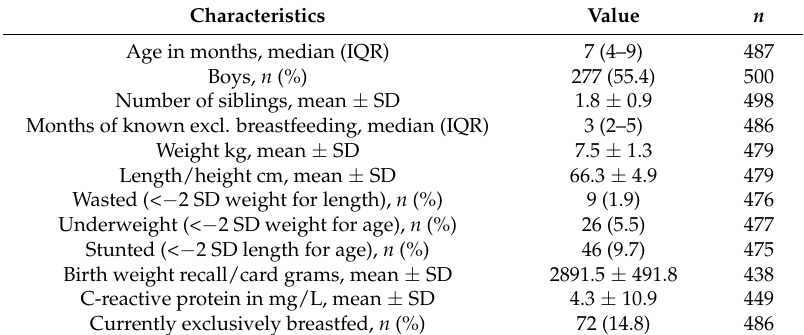
Table 1. Infant characteristics in a nutritional survey in mother and infant pairs in Bhaktapur, Nepal.